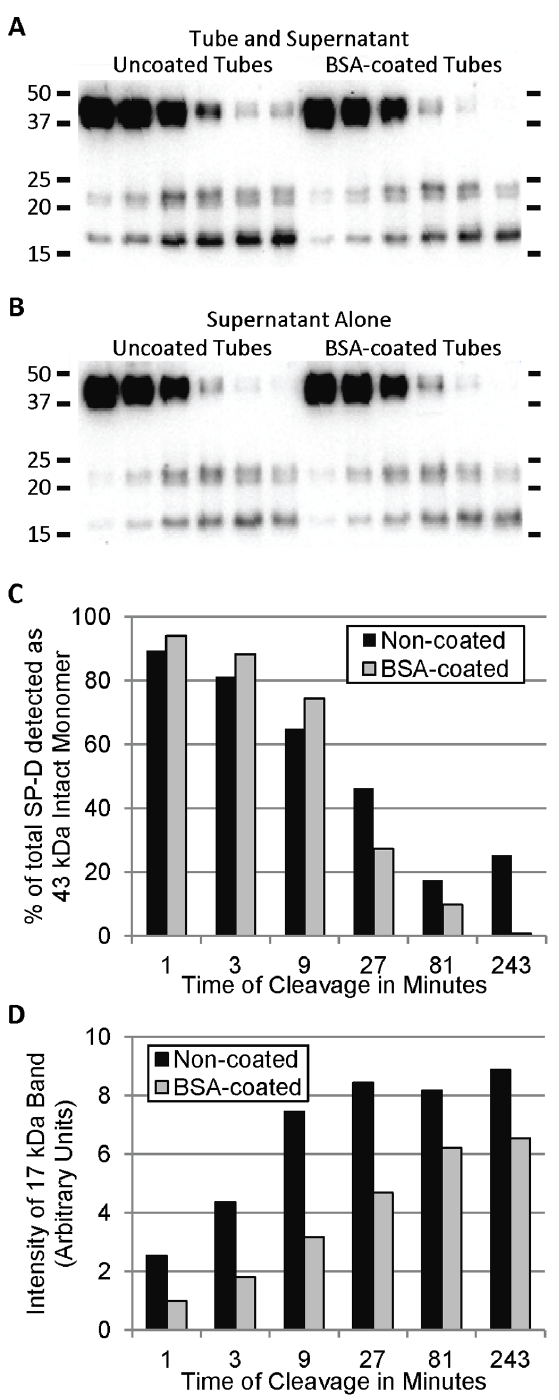
Figure 6. MMP-9-mediated Cleavage of SP-D is Affected by Adsorption to Polypropylene Tubes. Western blots of cleaved SP- D from either tubes and supernatants combined (A) or from supernatants alone (B). Cleavage was performed in both uncoated (first 6 lanes) and BSA-coated (last 6 lanes) tubes, and samples were analyzed after incubations for 1, 3, 9, 27, 81, and 243 minutes at 37 u C. For (C) and (D), bands from the Western blot shown in (A) were quantified using ImageJ software. Western blots are representative of three independent experiments.